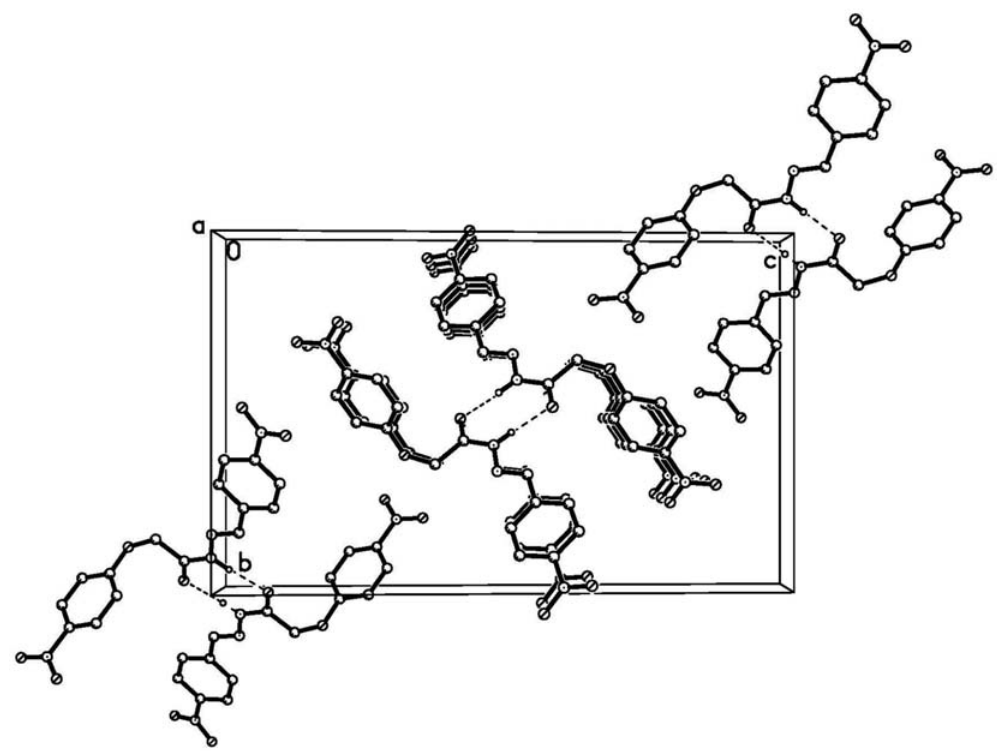
Figure 4. Molecular packing diagram of 2 . Hydrogen bonds are shown as dashed